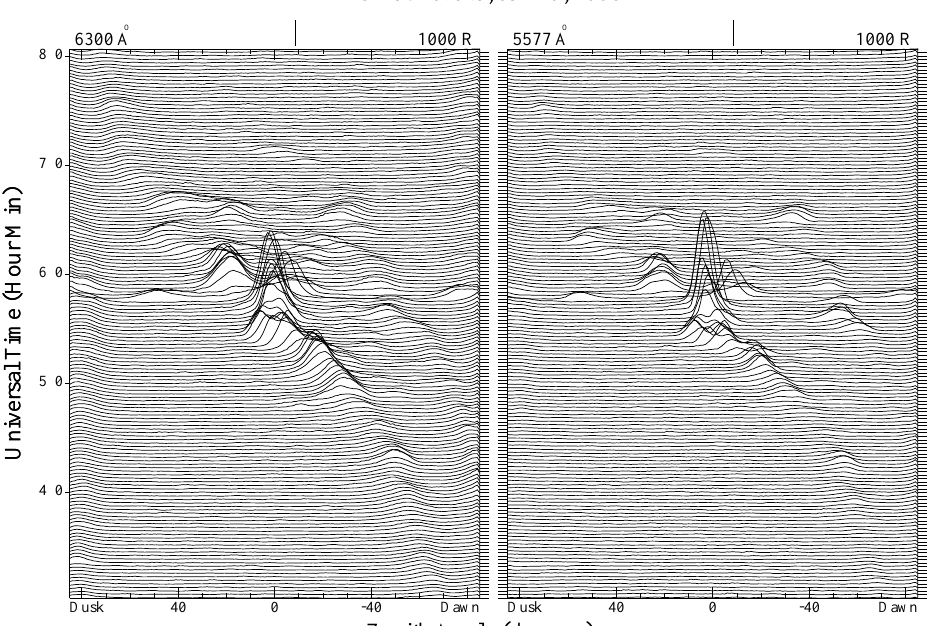
Fig. 12. Plots of MSP scans from 0300 to 0800 UT on Janu- ary 19, 1998. The data are each averaged for 2 min. Vertical bars at the top denote